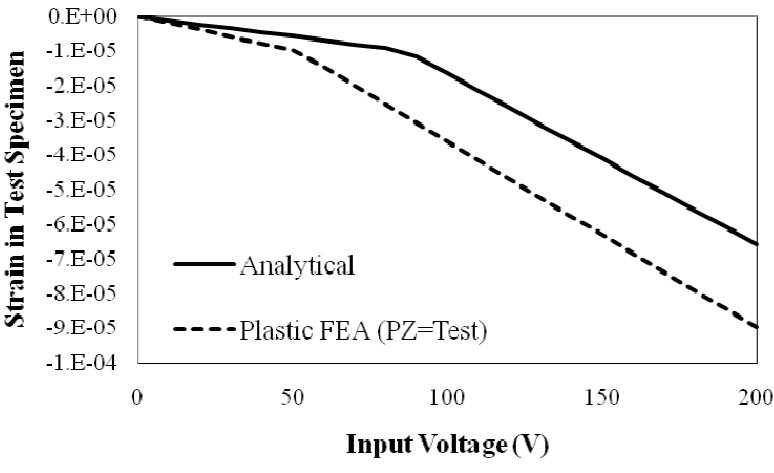
Figure 3. Comparison of strain measurements generated analytically and with finite